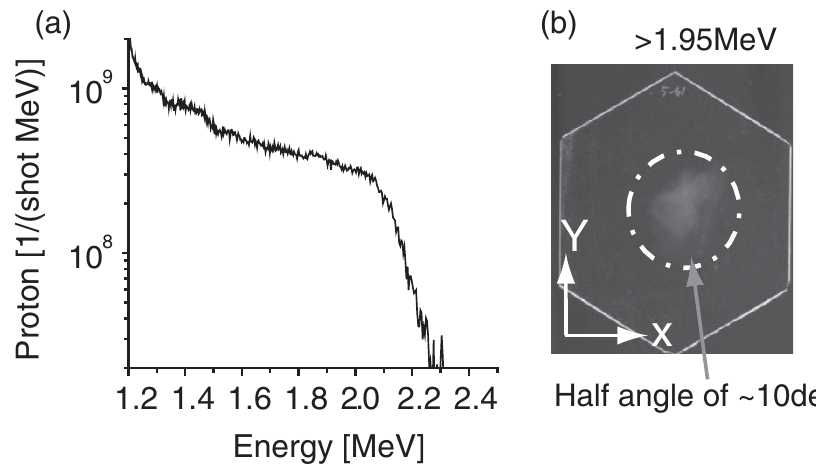
FIG. 2. (a) Typical time-of-flight proton energy spectrum from the polyimide tape source (laser target). (b) Typical transverse spatial profile of a proton bunch within the energy range of 1 : 9 MeV < E < 2 : 2 MeV , as measured with the CR-39 nuclear track detector. The x and y axes in the figure correspond to those in Fig.